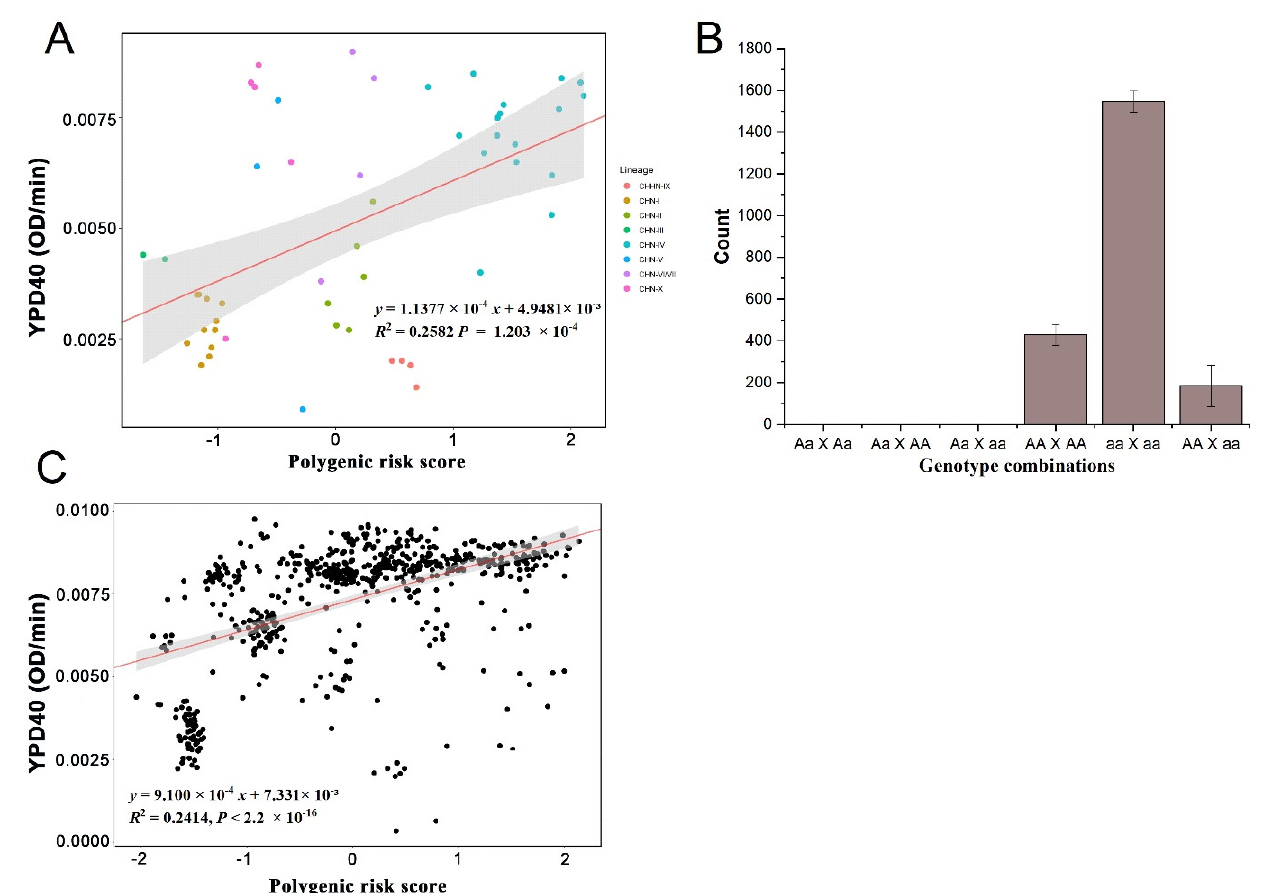
Figure 3. Relation between PRS and YPD40. ( A ) The linear relationship between PRS and 52 parental strains. ( B ) Distribution of combinations of genotypes on one locus from two parents of 613 F1 hybrids. The situations in which both parents were of homozygous genotype (AA × AA, aa × AA, aa × aa) accounted for 99.96% ± 0.04%. When both parents were homozygous genotypes, the genotypes of the F1 hybrids at this locus could be predicted with high accuracy. ( C ) The linear relationship between PRS and 613 F1 hybrids.